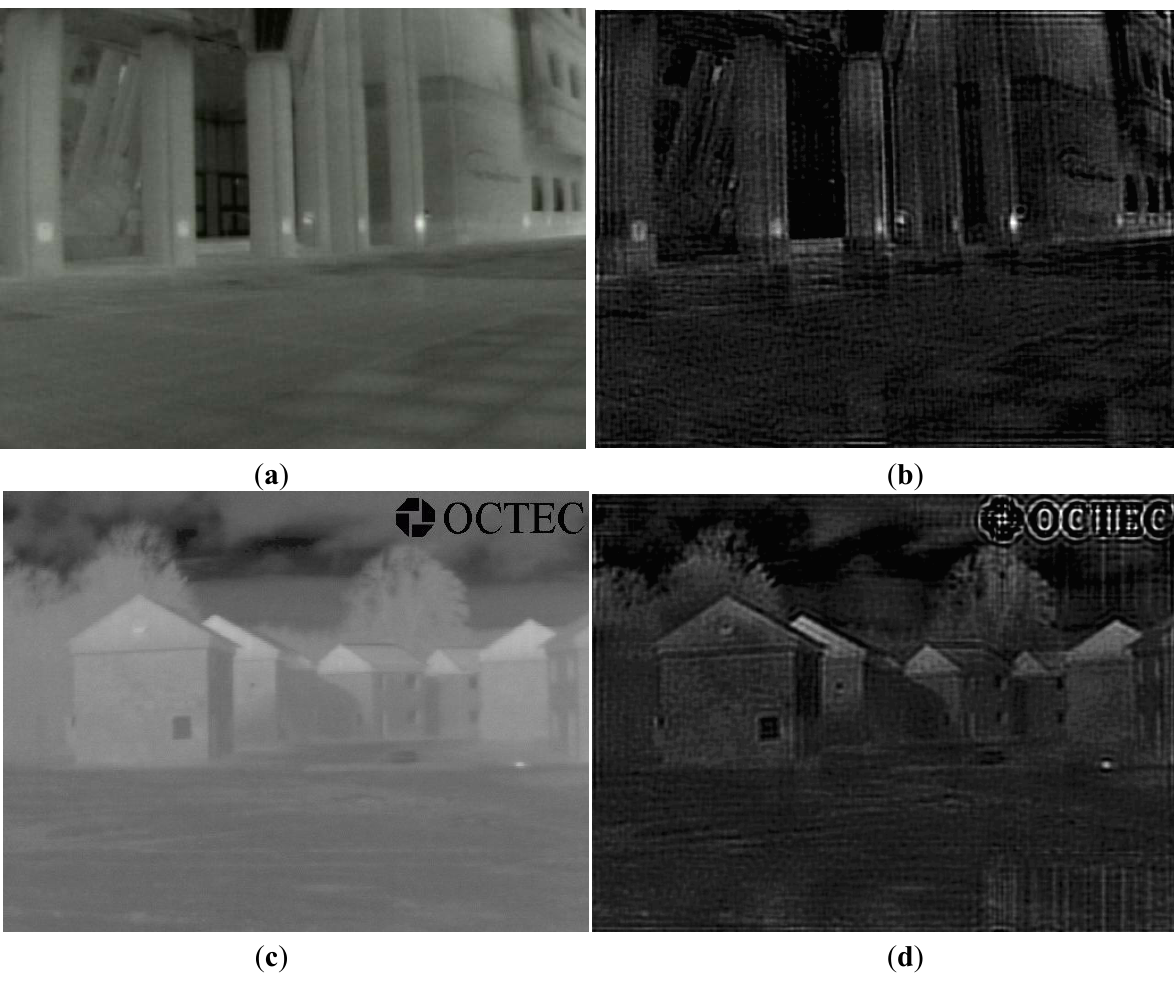
Figure 3. Examples of IRE image transformation using the designed inverse filter. ( a ) Original IR Image 1; ( b ) Transformed IR Image 1 via the inverse filter; ( c ) Original IR Image 2; ( d ) Transformed IR Image 2 via the inverse